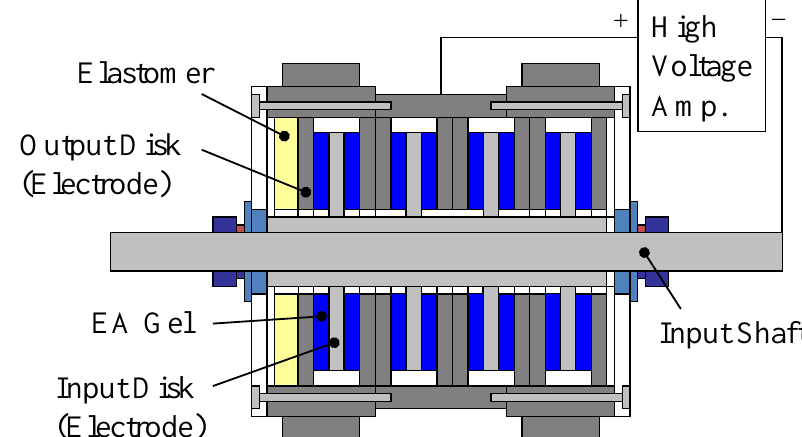
Figure 7. Clutch with multiple EA gel sheets.